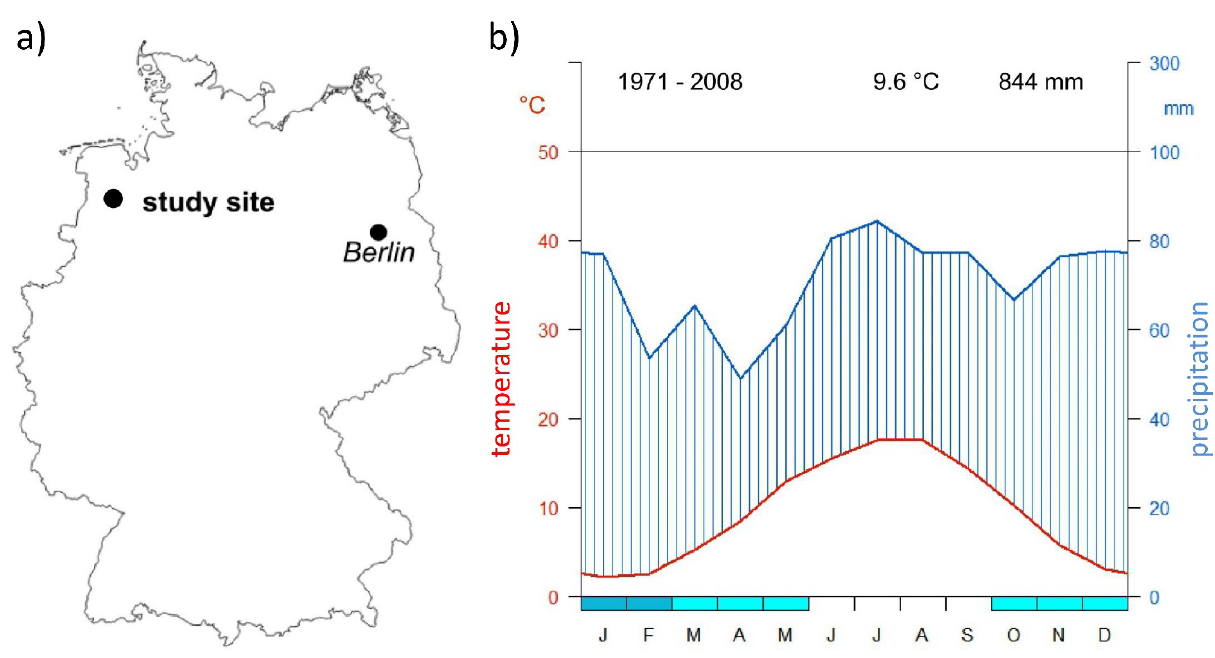
Figure 1. a) Location of the study site at Ramsloh, north-west Germany and b) climate graph (Walter & Lieth 1967) for the meteorological stations at Saterland-Ramsloh (precipitation, mm) and Dörpen (temperature, °C), which are located 4 km and 26 km from the site, respectively. The right-hand vertical axis indicates precipitation in mm per calendar month. On the horizontal axis, dark blue panels indicate months during which frost events certainly occur, and light blue panels those when frost may occur. Data provided by the German Weather Service DWD (Deutscher